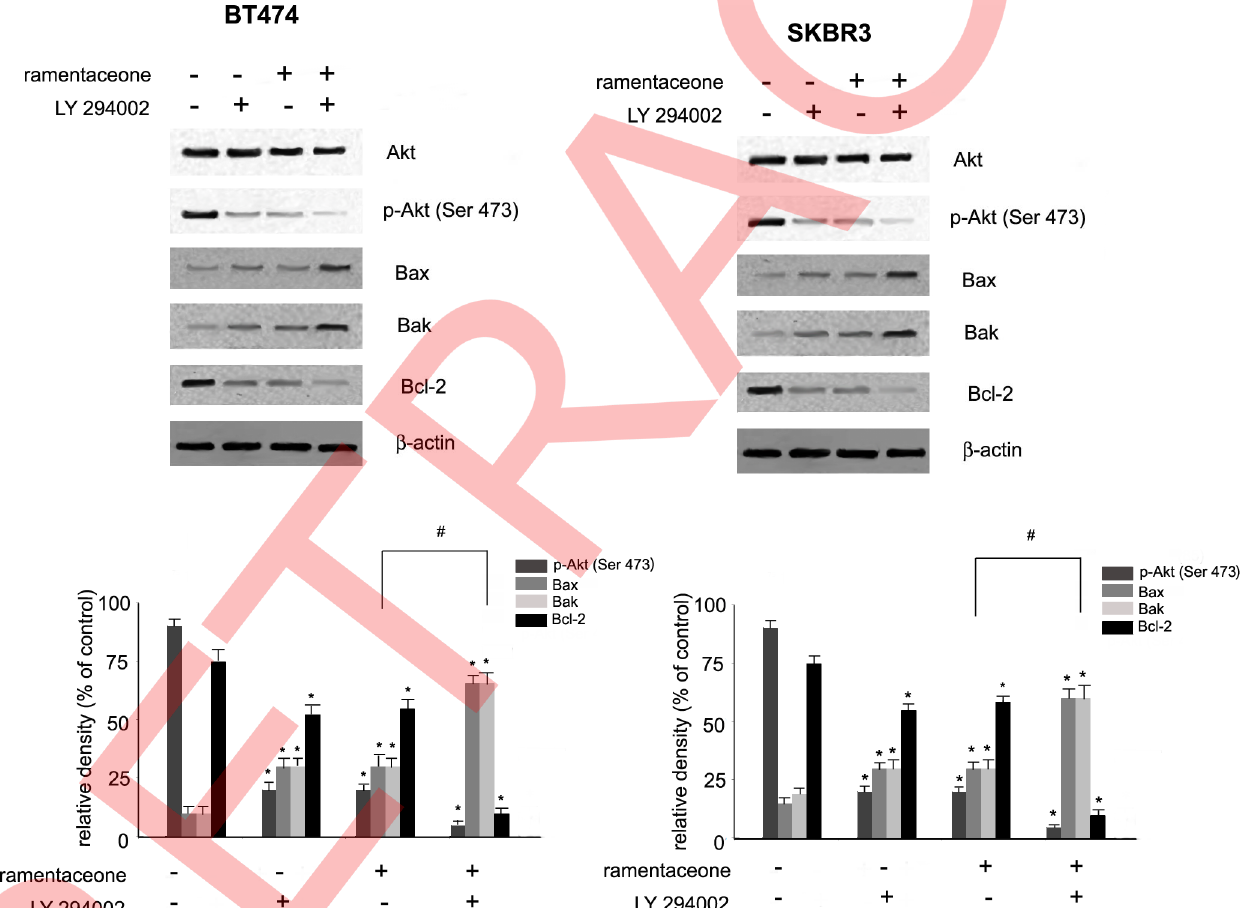
Fig 7. The role of PI3K inhibition in ramentaceone-mediated apoptosis induction. BT474 and SKBR3 cells were pre-treated with the PI3K inhibitor LY294002 (5 μ M) after which cells were treated with ramentaceone (5 μ M) for 24 h. Bax, Bak, Bcl-2 levels were assessed by Western blot analysis. Protein levels were determined by densitometric analysis. Values represent mean ± SD of three independent experiments. p < 0.05 ( * ) indicates differences between control and ramentaceone-treated cells. p < 0.05 (#) indicates differences between ramentaceone-treated and LY294002 pre-treated